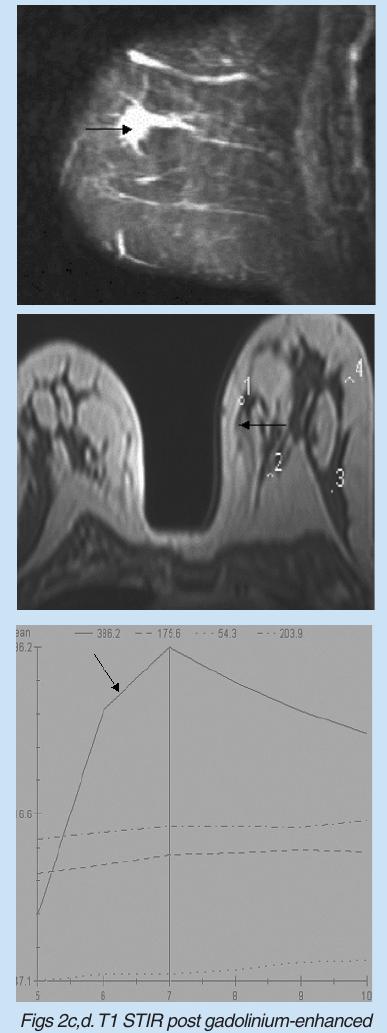
Figs 2c,d.T1 STIR post gadolinium-enhanced image of the same patient as in Fig.2a demonstrates focal enhancement of the can- cer (region of interest 1) in Fig.2d, and the cor- responding curve for this lesion (continuous line curve, arrow) shows the rapid initial wash in rise and the delayed washout typical of can- cer.